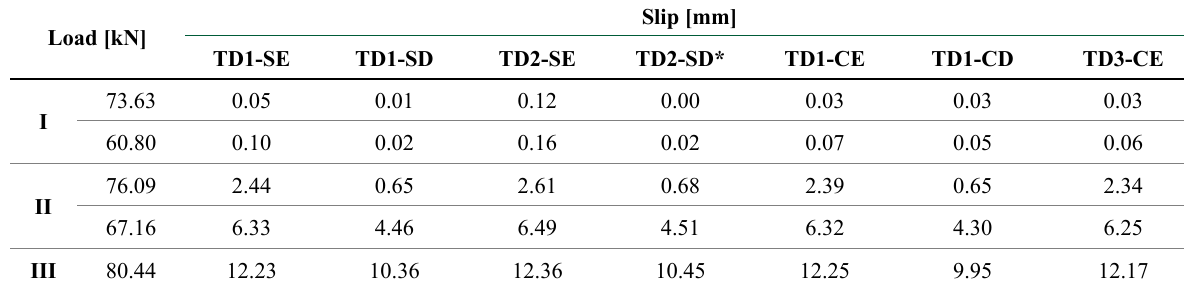
Table 3: Slip corresponding to the loading phases